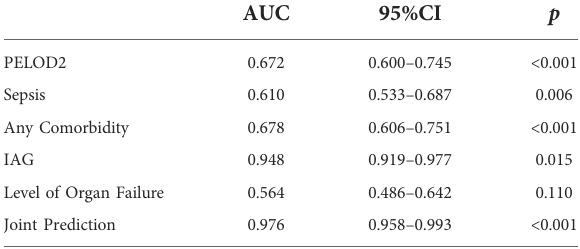
TABLE 5 AUC of various indicators predicting death 28 days after